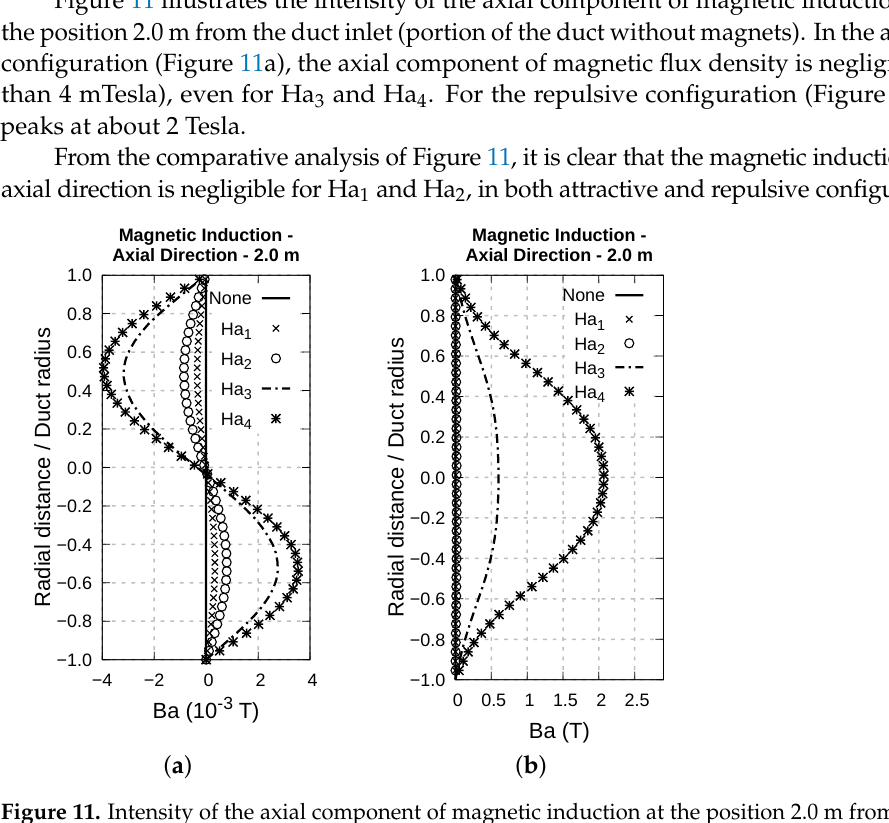
Figure 11. Intensity of the axial component of magnetic induction at the position 2.0 m from the duct inlet for ( a ) the attractive configuration and ( b ) the repulsive